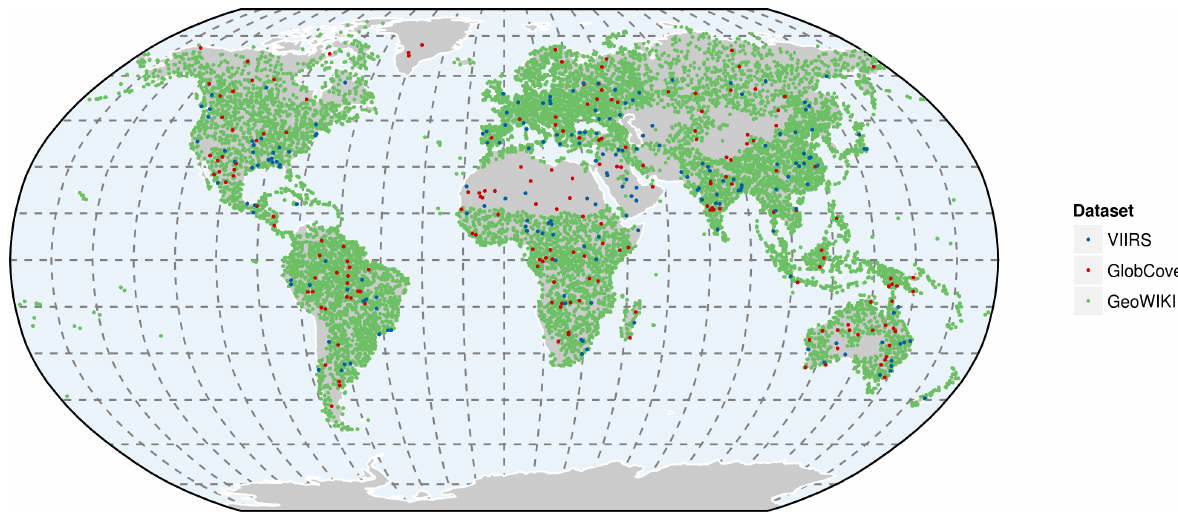
Figure 3. Distribution of the reference samples used for the validation of the 250-m Unified Cropland